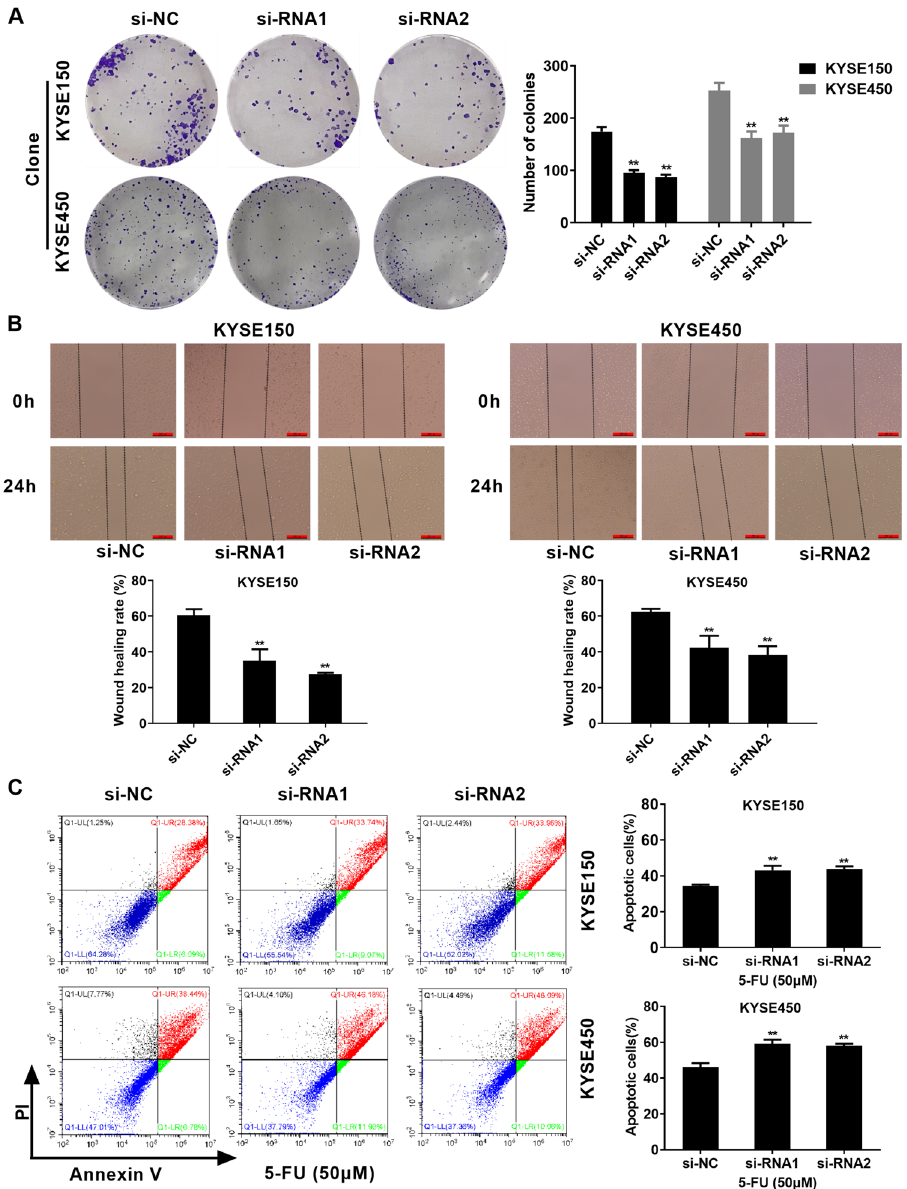
Figure 2. SNHG6 promotes colony formation and migration, while suppresses apoptosis of EC cells. ( A ) Transfection of si-RNAs inhibits colony formation of EC cells. ( B ) Transfection of si-RNAs inhibits migration of EC cells. ( C ) Transfection of si-RNAs promotes apoptosis of EC cells. **P < 0.01, compared with si-NC group (Two-way Student’s